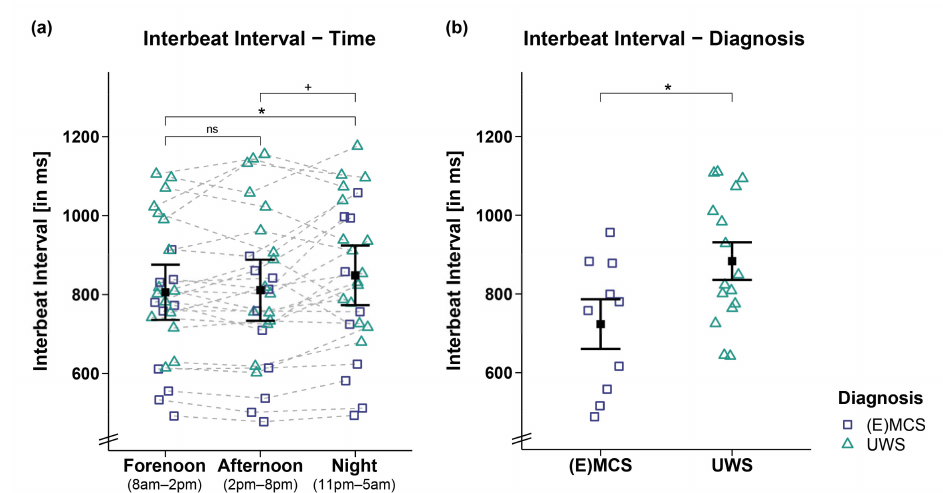
Figure 1. Interbeat interval (IBI) separately for time and diagnosis contrasts. ( a ) While patients’ IBIs were larger during the night as compared to the day (i.e., forenoon, afternoon), they did not differ between fore- and afternoon. ( b ) Patients in UWS showed larger IBIs than patients in (E)MCS. Error bars represent the mean and 95% confidence interval. * p < 0.05; + p ≤ 0.1; ns = not significant. Abbre- viations: (E)MCS = (emergence from) minimally conscious state; UWS = unresponsive wakefulness syndrome; ms = milliseconds.